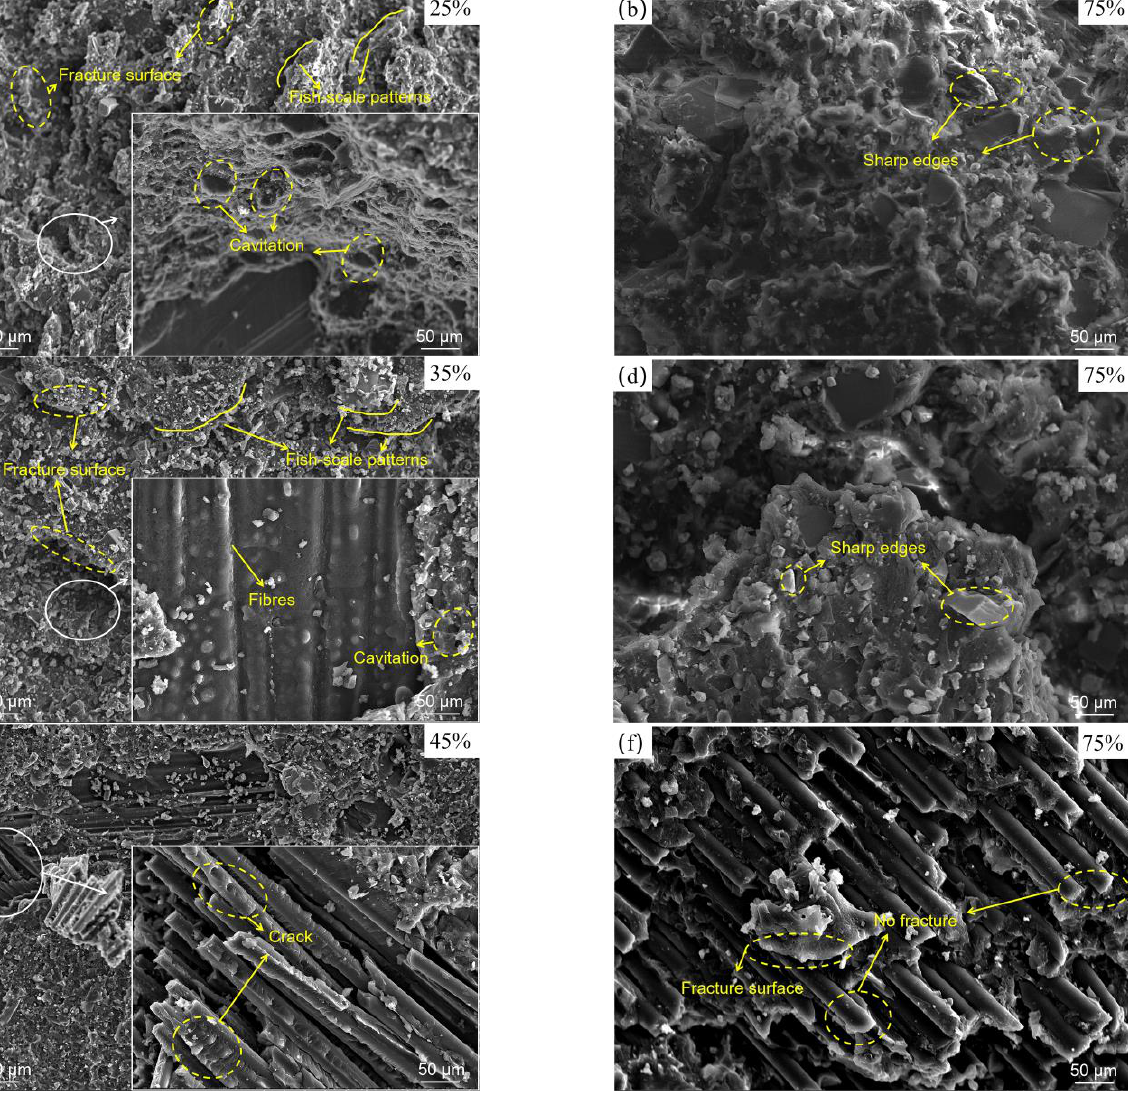
Figure 9. Micro-failure morphology of joints under different load levels: ( a , b ) [0/90] 4s , ( c , d ) [0/45/ − 45/90] 2s , and ( e , f ) [45/ − 45] 4s